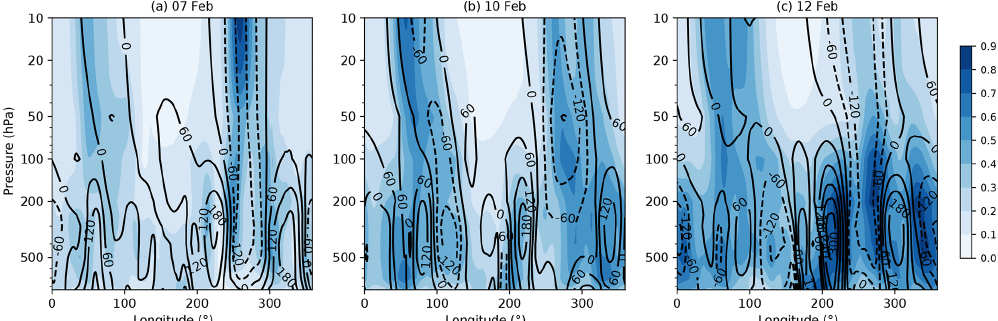
Figure 6. Zonal cross sections for 50 ◦ N of the ensemble spread of geopotential height predicted for (a) 7, (b) 10 and (c) 12 February 2018. Superimposed contours represent observed geopotential anomalies ( m ) with respect to the 1980–2010 climatology. Solid lines represent anticyclonic (positive) anomalies and dashed lines cyclonic (negative) anomalies. Anomaly is normalized by